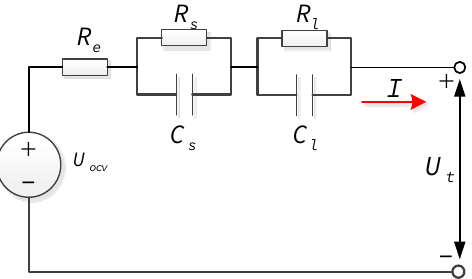
Figure 1. The second-order resistance–capacitance (RC) equivalent circuit model.